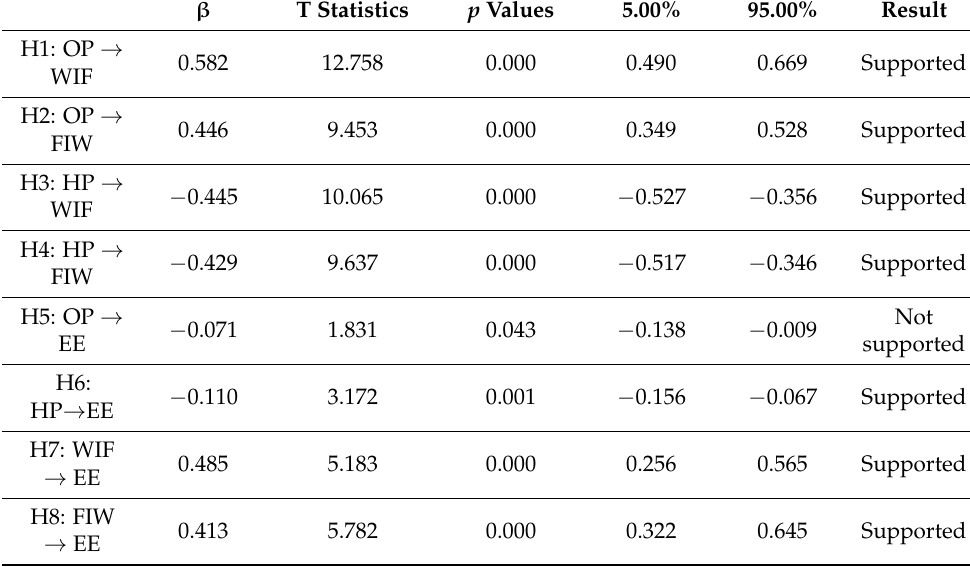
Table 4. Results of direct